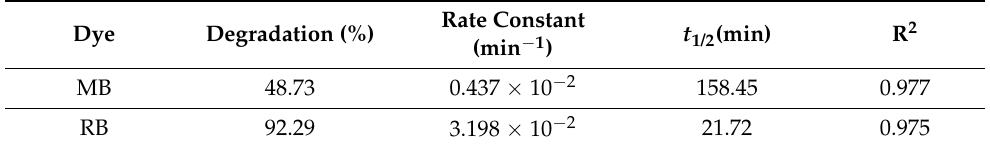
Table 2. Kinetic parameters for Ni-CoWO 4 toward dyes MB and RB.